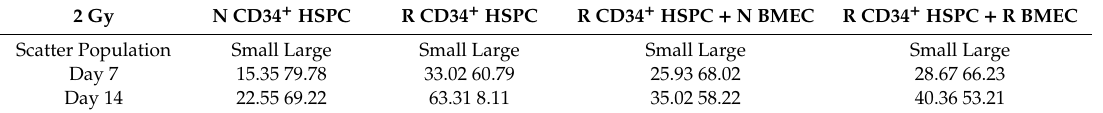
Figure 8. MF radiation and hBMEC altered scatter profile of HSPC. HSPC were irradiated with 2 Gy ( A , B ) or 4 Gy ( C , D ) for 7 or 14 days. Forward scatter was analyzed by flow cytometry. Table 1. CD34 + hSPC cell population percentages after 2 Gy MF radiation. Table 1. CD34 + hSPC cell population percentages after 2 Gy MF radiation.